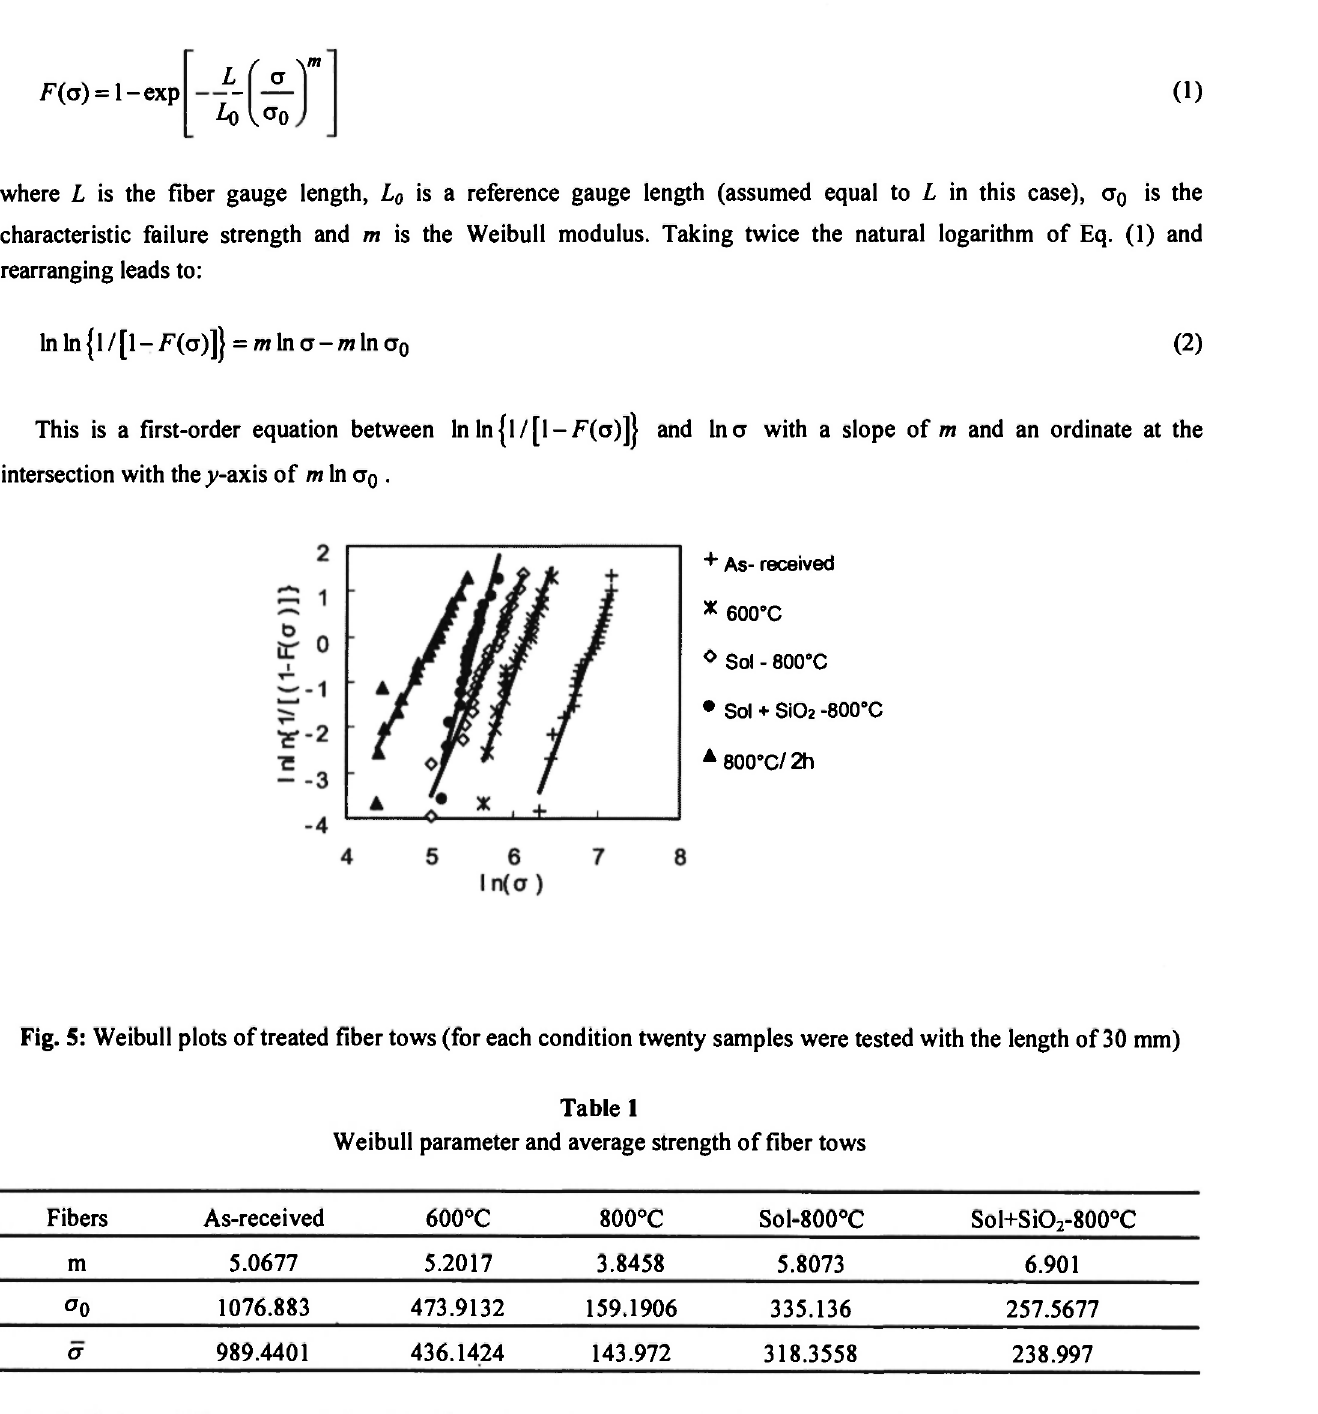
Fig. 5: Weibull plots of treated fiber tows (for each condition twenty samples were tested with the length of 30 mm)